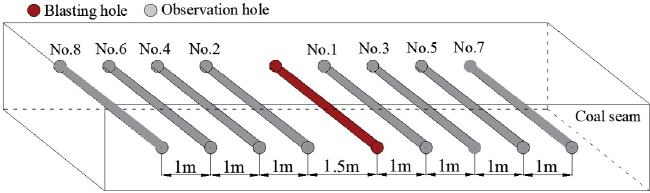
Fig 12. Schematic diagram of the drilling arrangement of the test working